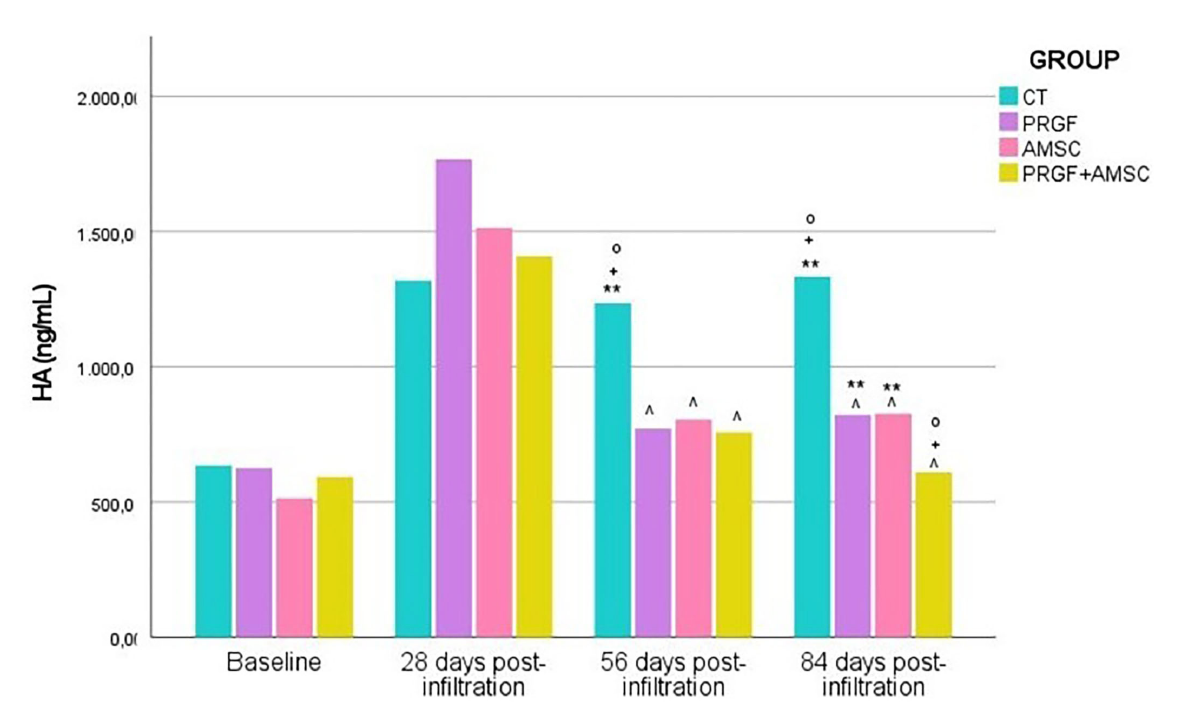
FIGURE4 HA serum levels (ng/mL) before infiltration and 28-, 56-, and 84-days post-infiltration in all treatment groups. HA, hyaluronic acid; CT, control; PRGF, plasma rich growth factors; AMSCs, adipose mesenchymal stem cells; PRGF + AMSCs, combination of plasma rich in growth factors with adipose mesenchymal stem cells. ∧ , significant differences with CT group; ◦ , significant differences with PRGF group; + , significant differences with AMSCs group; **, significant differences with PRGF + AMSCs